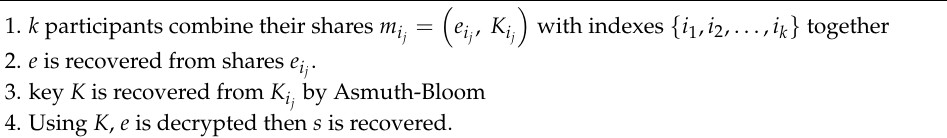
Algorithm 2. Secret Recovery of Krawczyk